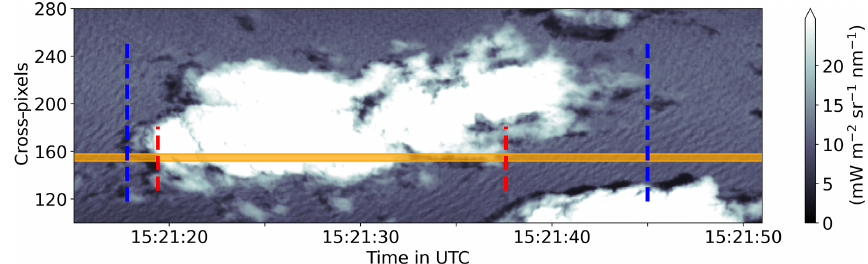
Figure 7. Cloud partly reaching into the FOV of the radar (orange swath), as measured by the imager’s 1600nm channel. Dashed lines indicate the along-track cloud length within the radar FOV (red) and maximum along-track cloud length for the entire across-track extension